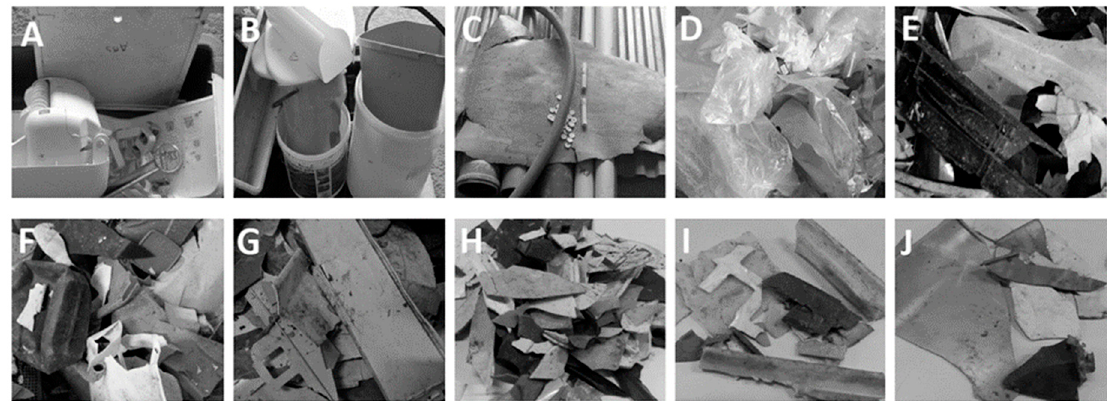
Figure 1. Illustrative examples of ABS ( A ), PP ( B ), PVC ( C ), and PE ( D ) in manually sorted CDW. PP ( E ), PE ( F ), and PS ( G ) after mechanical sorting, together with smaller-sized PP ( H ), PE ( I ), and ABS ( J ).